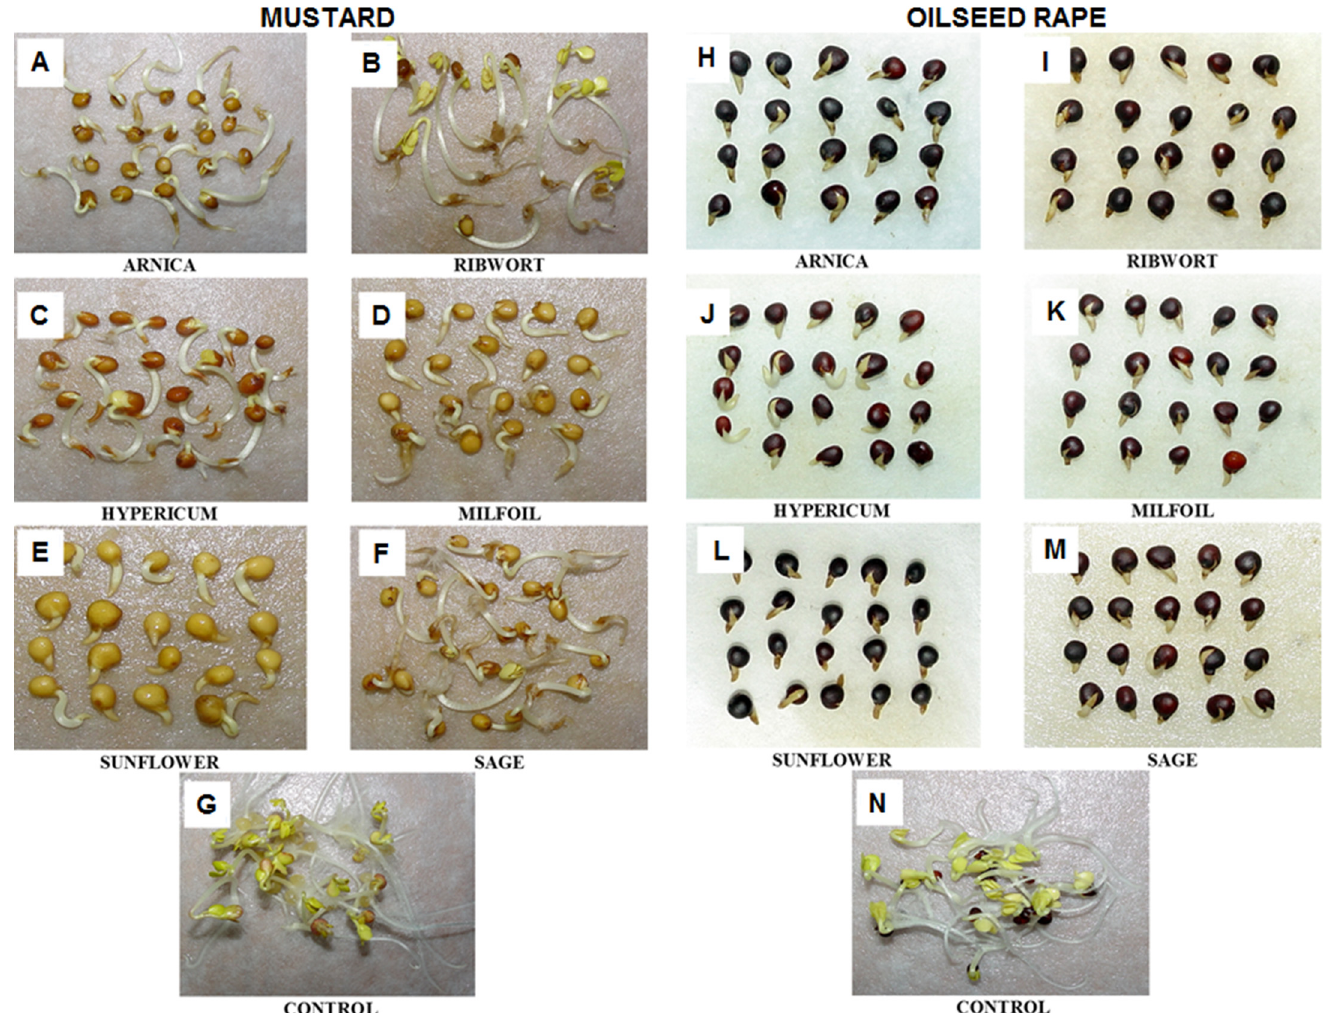
Figure 4. White mustard seedlings that were growing on the extracts of arnica ( A ), ribwort ( B ), hypericum ( C ), milfoil ( D ), sunflower ( E ) and sage ( F ). Control ( G )—mustard seedlings cultured only in water. Oilseed rape seedlings that were growing on arnica ( H ), ribwort ( I ), hypericum ( J ), milfoil ( K ), sunflower ( L ) and sage ( M ). Control seedlings of oilseed rape ( N ) were growing only in water. The plants that were exposed to the extracts were first germinated in water for 24 h and then were cultured in the extract for 48 h. Photos show three-day-old plants.